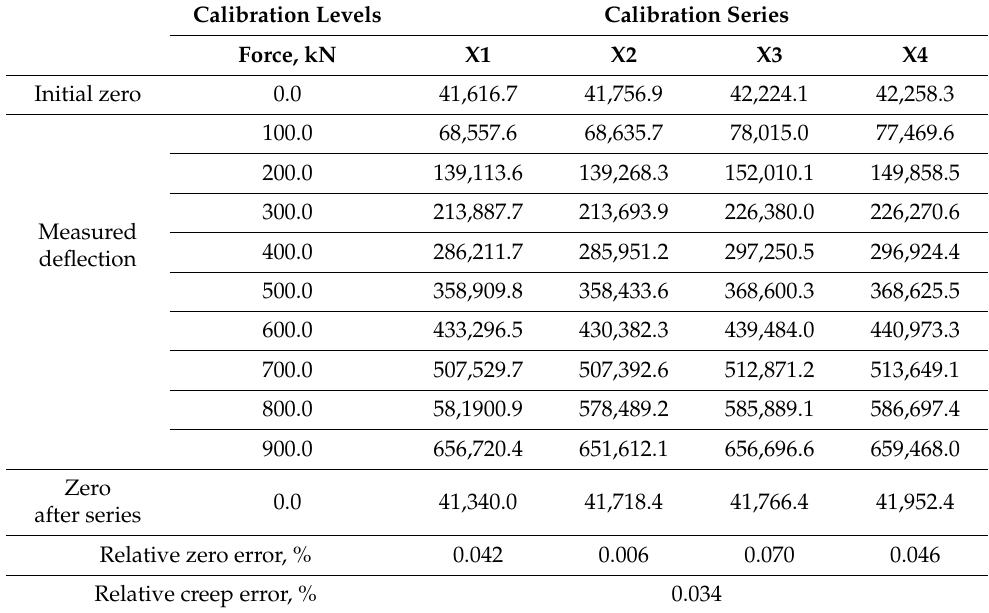
Table 2. Calibration